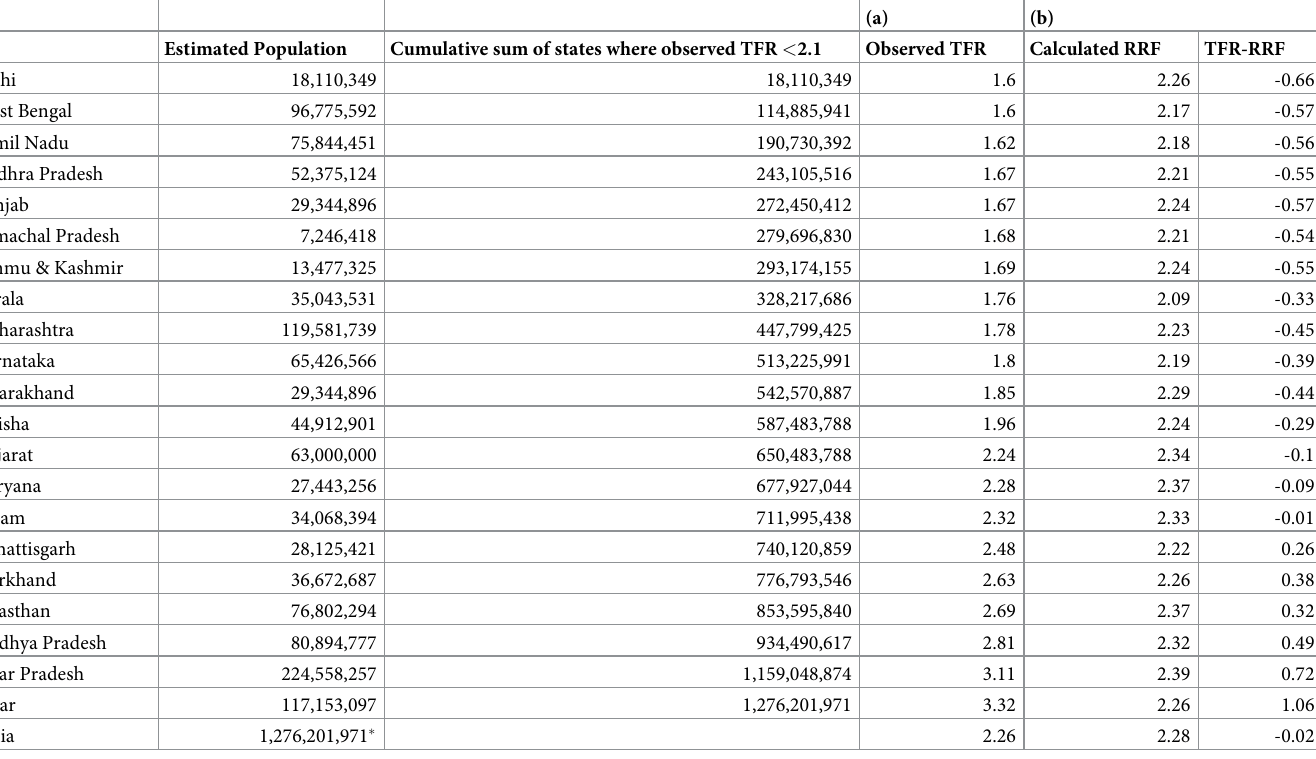
Table 1. Indian States, observed TFR (2016), RRF (2012–2016), and difference between the two, projected population (2017), ordered by observed TFR. Sources: Authors calculations based on [16–18]. Estimated Population Cumulative sum of states where observed TFR <